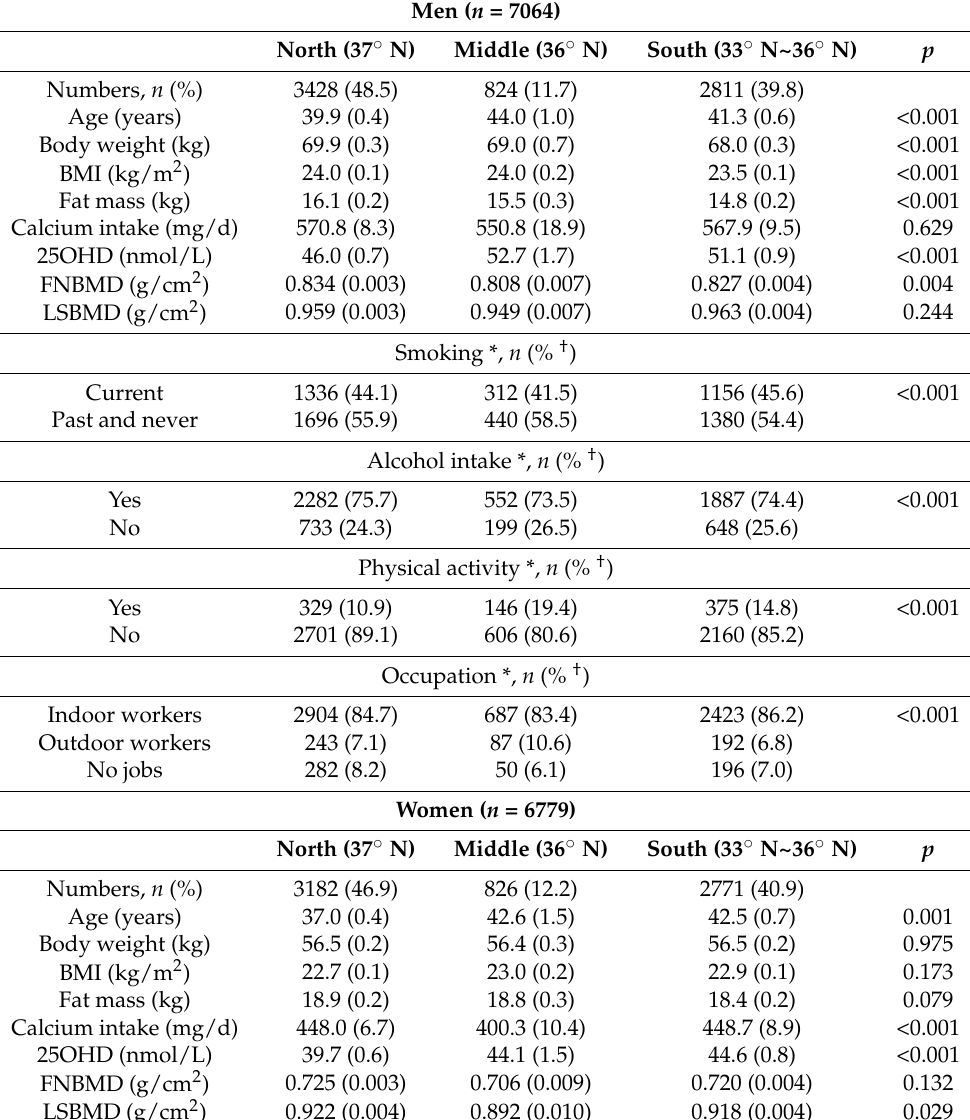
Table 1. General characteristics of study subjects by regions and